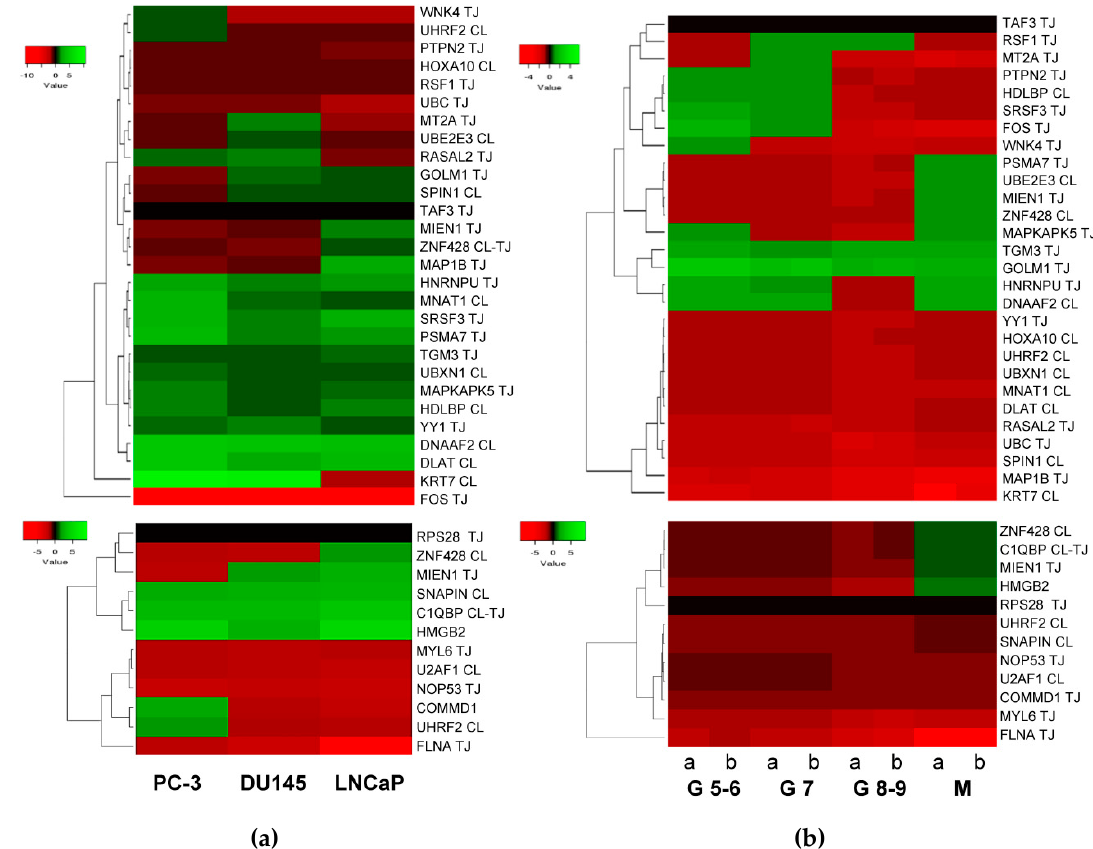
Figure 5. Heat map expression in prostate cancer: ( a ) Expression of HMGB1 interactome targets (upper panel) and HMGB2 interactome targets (lower panel) in 3 prostate cancer cell lines; ( b ) expression of HMGB1 interactome targets (upper panel) and HMGB2 interactome targets (lower panel) in prostate adenocarcinoma cases classified by Gleason (G) score groups or metastatic (M) tumors. CL, target detected in the PC-3 library. TJ, target detected in the prostate adenocarcinoma library. Data extracted from Gene Expression Omnibus (GEO ) Accession: GSE21032.